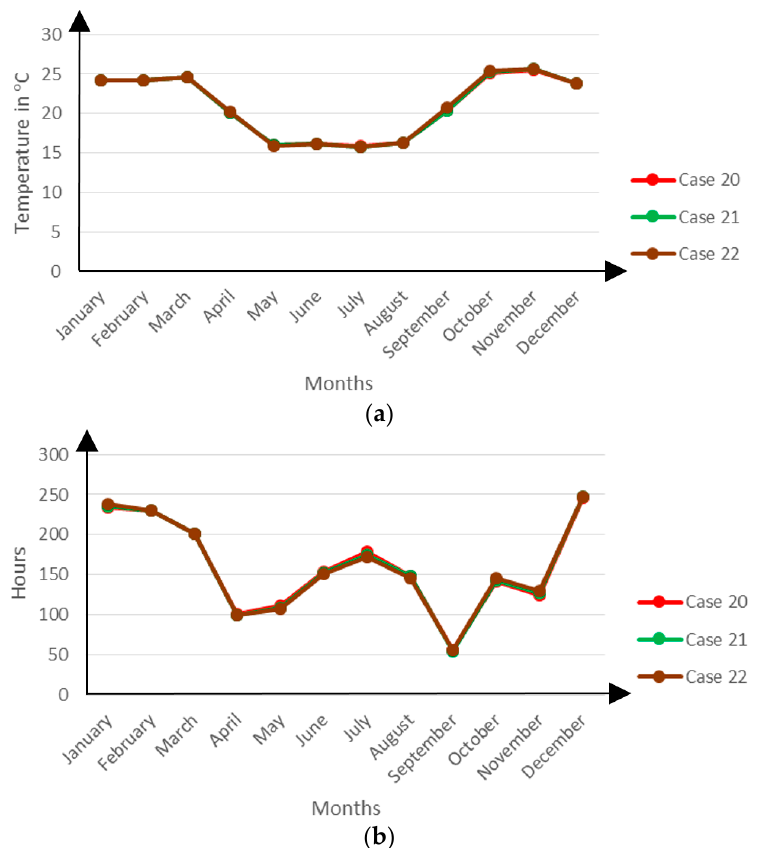
Figure 19. Monthly mean zonal temperatures ( a ) and discomfort hours ( b ) for Cases 20, 21 and 22.